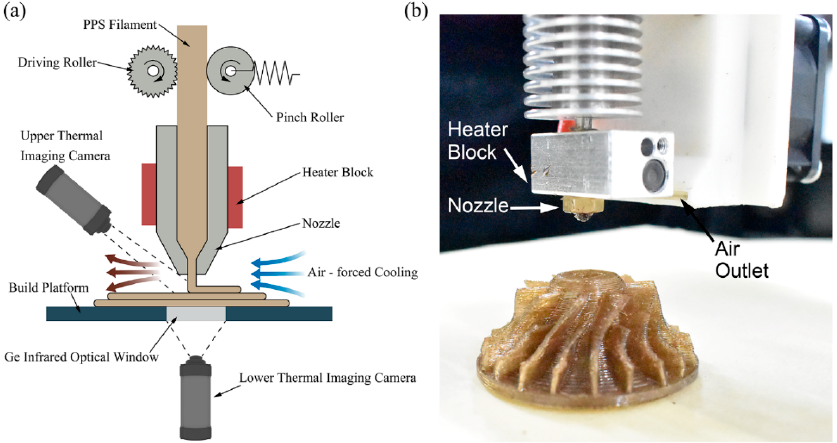
Figure 1. PPS 3D printing: ( a ) Schematic diagram of PPS 3D printing; ( b ) image of the extrusion head. Table 1. Printing parameters of 3D-printed PPS.